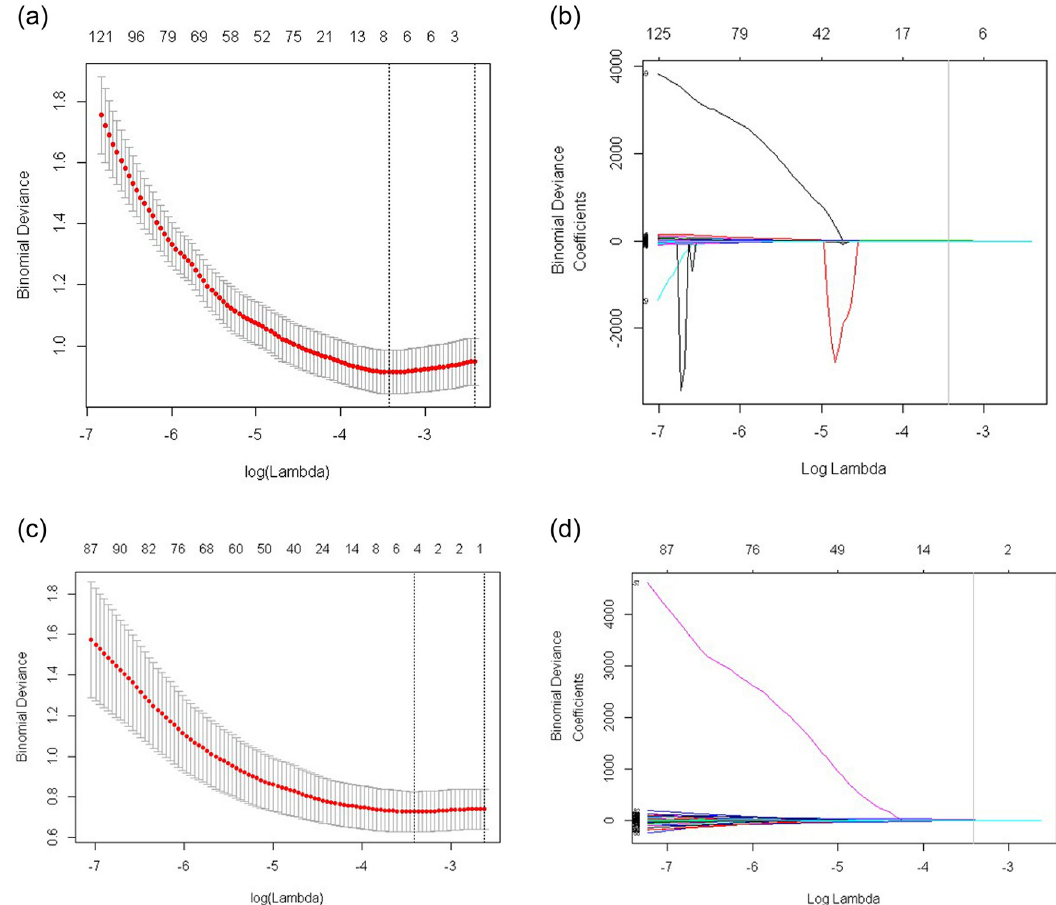
Fig 2. Texture feature selection using the least absolute shrinkage and selection operator (LASSO) logistic regression model. (A) Tuning parameter (lambda, λ ) selection in the LASSO model used 10-fold cross validation for 527 thyroid cancers. The mean deviance (goodness-of-fit statistics, red dots) was plotted versus log( λ ), error bars displaying the range of standard error. Dotted vertical lines were drawn at the point of minimum deviance ( λ value = 0.03229), and at the point where maximum λ was obtained among errors smaller than the standard error of minimum deviance ( λ value = 0.08984). (B) LASSO coefficient profiles of the 730 texture features. A coefficient profile was plotted versus log( λ ). The gray vertical line was drawn at the value selected using 10-fold cross validation, where the optimal λ resulted in 8 nonzero coefficients. (C) Tuning parameter (lambda, λ ) selection in the LASSO model used 10-fold cross validation for 389 conventional PTCs < 20-mm. The mean deviance (goodness-of-fit statistics, red dots) was plotted versus log( λ ), error bars displaying the range of standard error. Dotted vertical lines were drawn at the point of minimum deviance ( λ value = 0.0329208), and at the point where maximum λ was obtained among errors smaller than the standard error of minimum deviance ( λ value = 0.072595). (D) LASSO coefficient profiles plotted versus log( λ ), gray vertical line was drawn at the value selected using 10-fold cross validation, where the optimal λ resulted in 4 nonzero